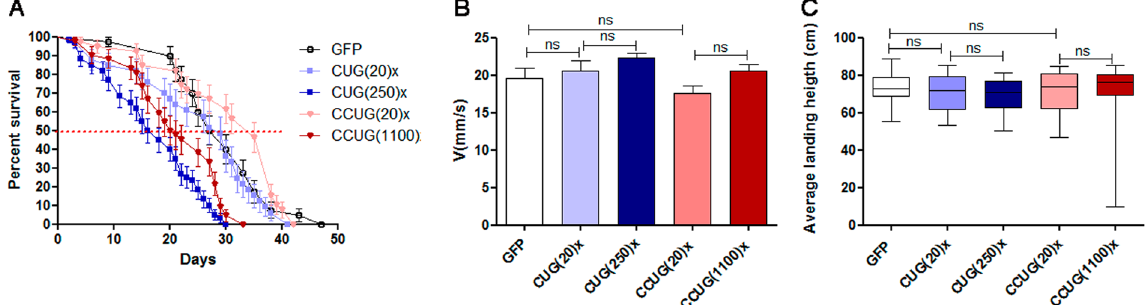
Figure 7. Expression of expanded CUG or CCUG repeats in fly heart alters survival but not locomotion. ( A ) Average percentage of live flies, with the indicated genotypes, versus age (in days). The GMH5-Gal4 driver was used to induce expression of the indicated genotypes in cardiomyocytes. Horizontal dotted line marks the median survival. Flies expressing expanded CUG (CUG(250) × ; n = 100) or CCUG (CCUG(1100) × ; n = 97) repeats had a reduced lifespan compared to control flies (GFP; n = 100) or flies expressing the short versions of the repeats (CUG(20) × ; n = 95 and CCUG(20) × ; n = 99). The differences in survival curves were highly significant (p < 0.0001, log-rank test). ( B ) Histogram showing the climbing velocity of flies as the mean speed ± SEM in mm/s. Expression of long CUG or CCUG repeats in heart did not modify climbing velocity compared to control flies or flies expressing the short versions of repeats. ( C ) Notched box plot showing the median and the distribution of the average landing height data obtained in the flight assay using flies with the genotypes indicated. * p < 0.05, ** p < 0.01, *** p < 0.001 (Student’s t